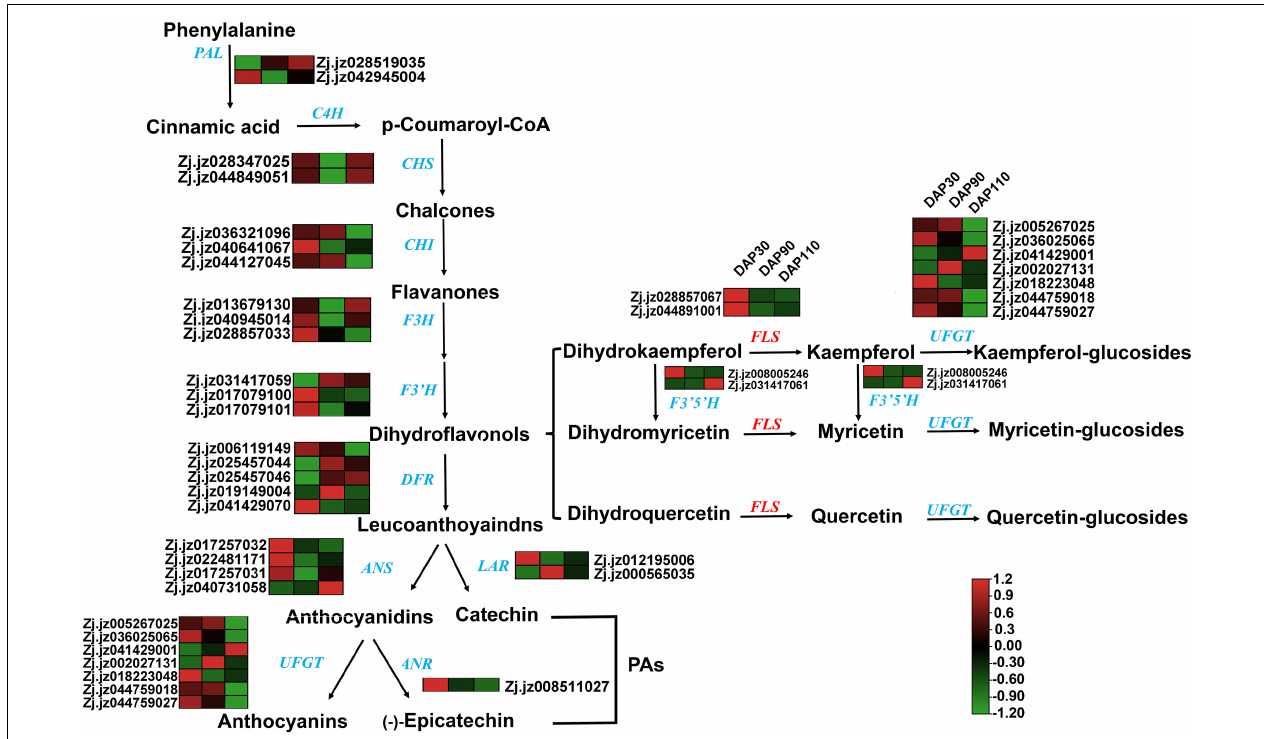
FIGURE 4 | The flavonoid synthesis pathway and related gene expression patterns in jujube skins. Gene names are given in blue or red italics, and arrows represent enzymatic